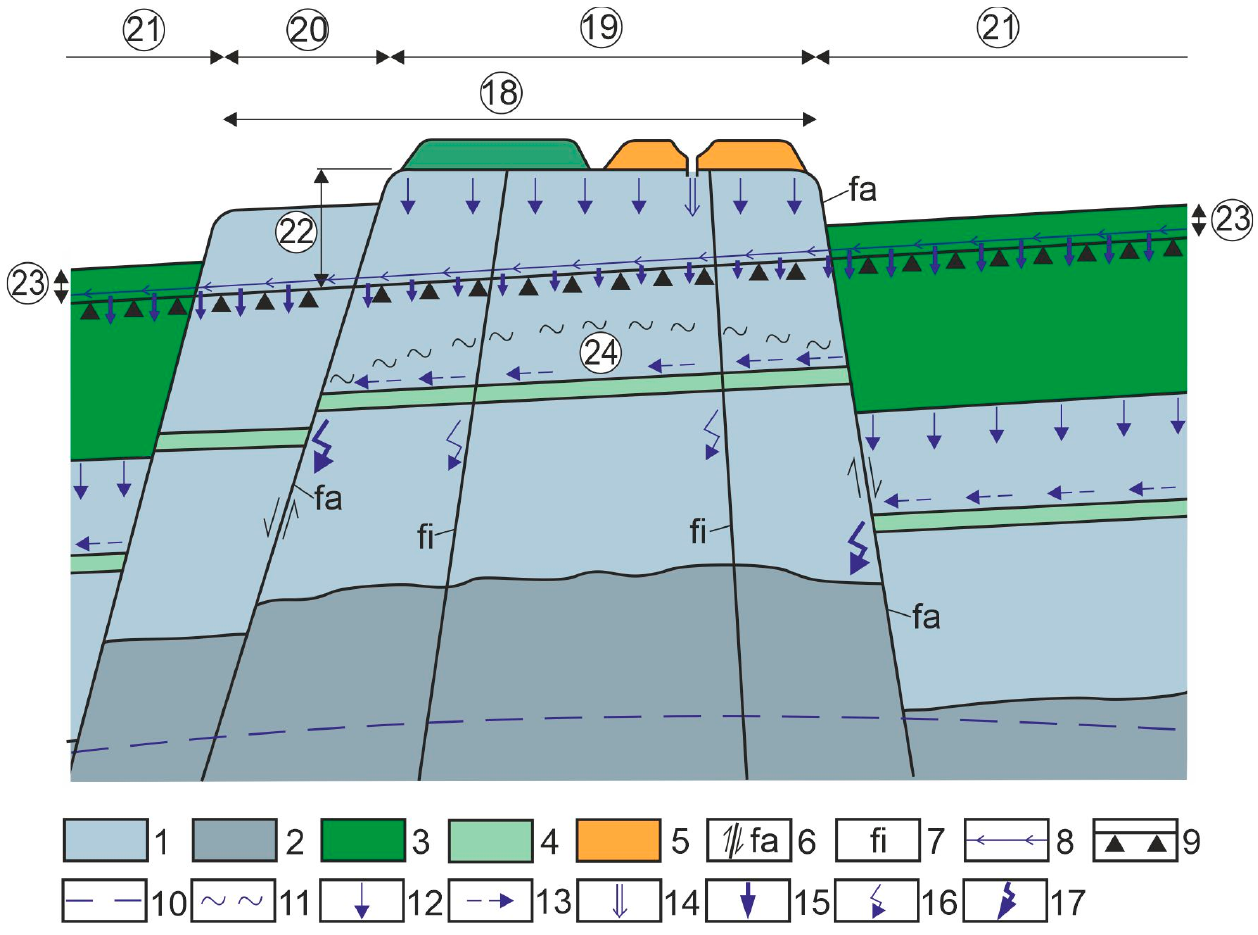
Figure 12. Mixed epigene karst system in early phase in cross-section. Legend: 1. Young (Eocene, Cretaceous) limestone, 2. Older (Triassic) carbonates, 3. Impermeable and water storage cover, 4. Impermeable, partly impermeable intercalation, 5. Permeable cover, 6. Fault and fault scarp, 7. Fracture, 8. Stream, 9. Valley floor, 10. Regional groundwater level, 11. Level of perched water table, 12. Areal, diffuse infiltration, 13. Water motion above impermeable intercalation, 14. Local water inflow, 15. Linear seepage, 16. Water motion along fracture, 17. Water motion along fault, 18. Horst elevated to summit position 19. Epigenetic-antecedent valley section, 20. Epigenetic valley section, 21. Cryptopeneplain with inheriting valley section, 22. Side of epigenetic-antecedent valley section, 23. Side of valley section that developed in non-karstic rock, 24. Perched water table.